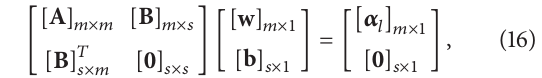
response surface for the POD coefficients that can be